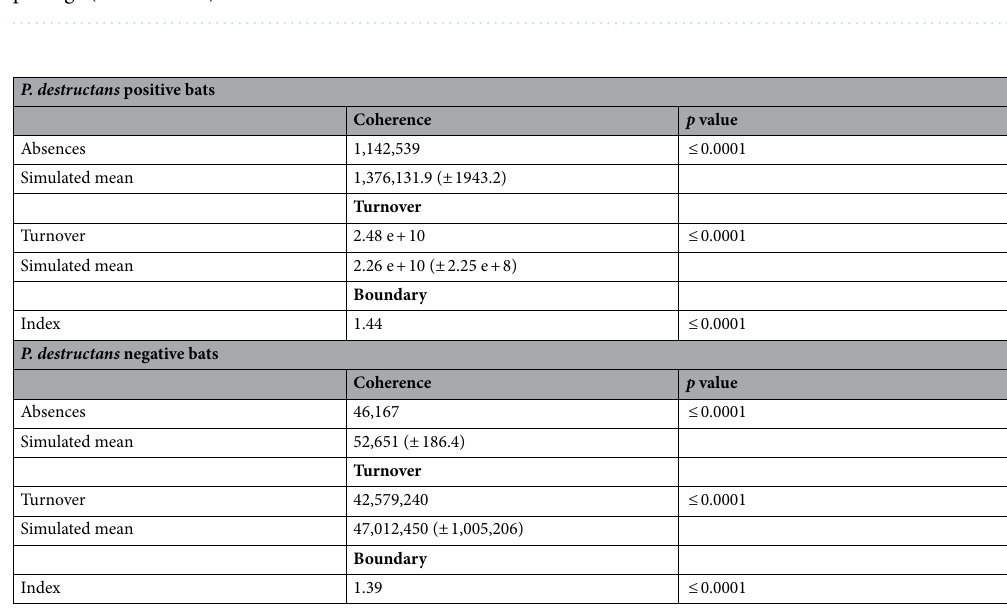
Figure 3. Site by species incidence matrix for OTUs on P. destructans positive/negative bats describing the actual metacommunity patterns. Black bars represent each OTUs (x-axis) range across bat samples (y-axis). EMS analysis suggests a Clementsian structure for P. destructans positive and a nested structure for P. destructans negative bat microbial metacommunities. Plots were produced using the Imagine function in the metacom package (version 1.5.3) in R 26 .